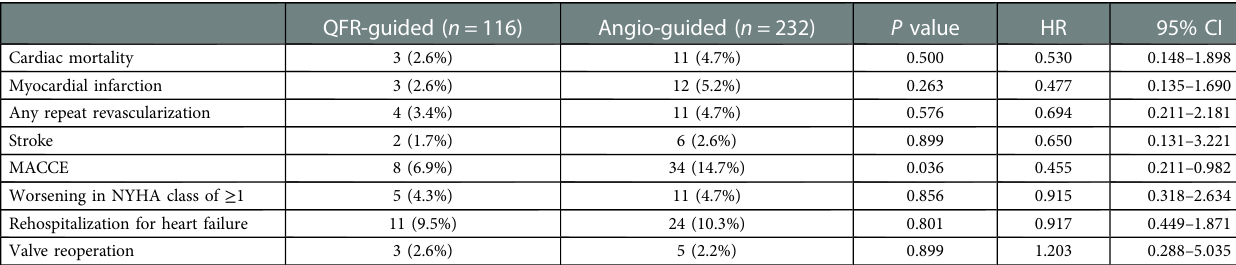
TABLE 4 Clinical end points at 1-year.